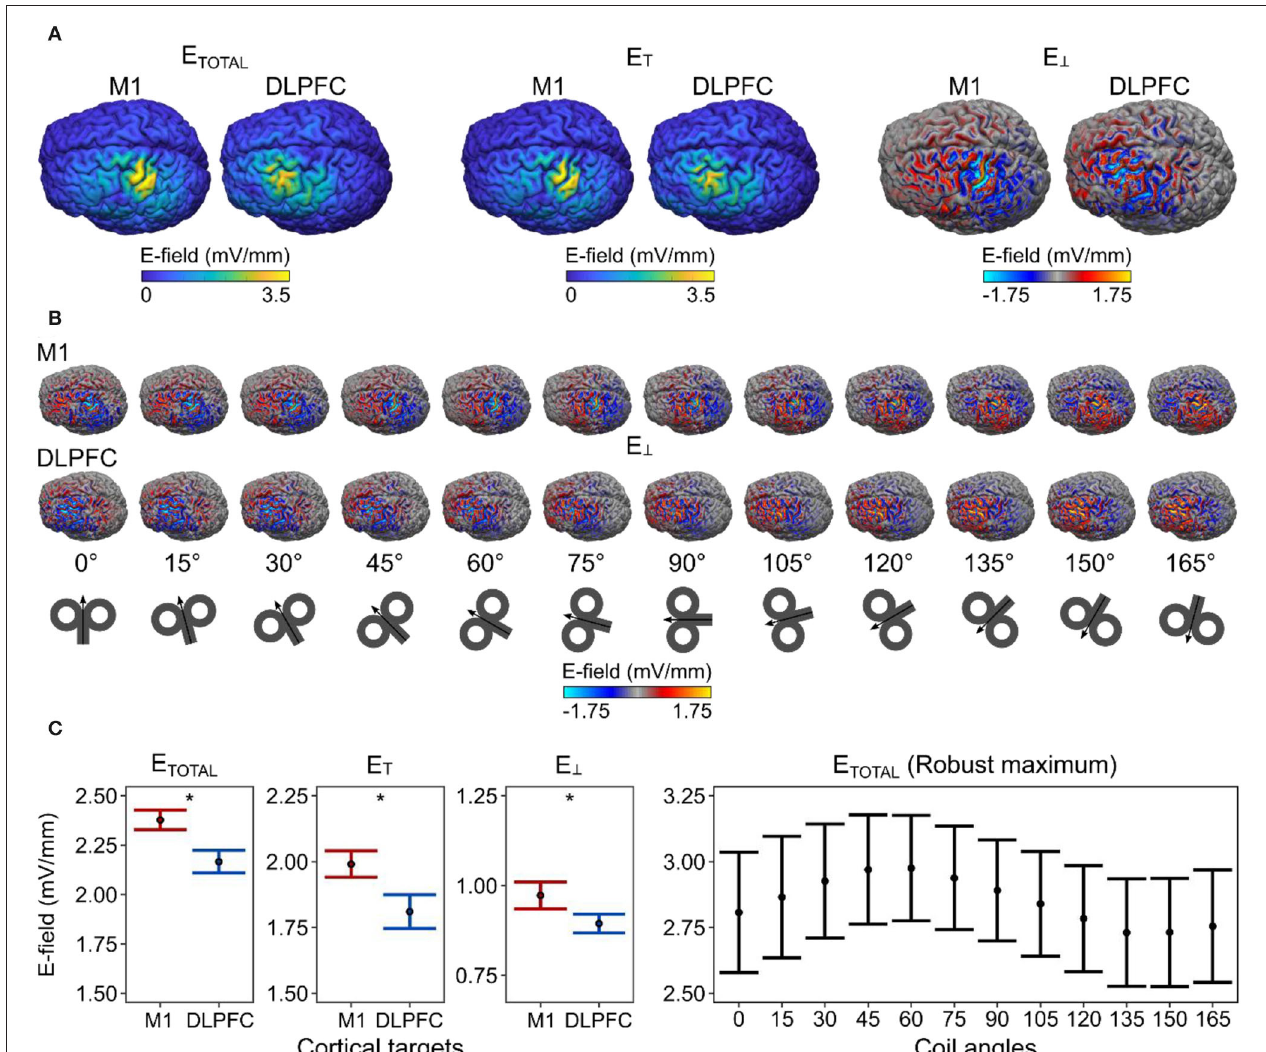
FIGURE 2 | Differences in macroscopic E-field strengths between M1 and DLPFC. (A) The spatial distribution of the E-field values and (B) the effect of coil angle on the E-field distribution projected over the gray matter surface in one example participant (ID = P21). (C) We observed a significantly stronger mean E-field in the M1, compared with the DLPFC. The robust maximum of the E TOTAL . E-field values correspond to gray matter surface compartment. Dots represent the mean, error bars correspond to 95% CIs. E-field values correspond to simulations run at 1% MSO. Asterisks indicate a significant effect of factor cortical target.